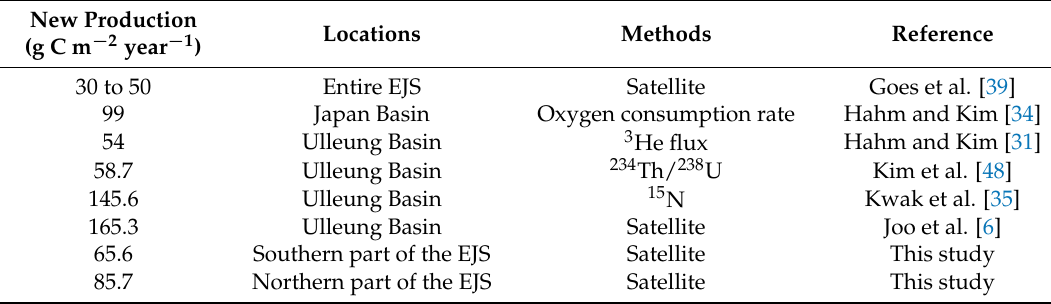
Table 2. Comparison of the annual new production in the East/Japan Sea